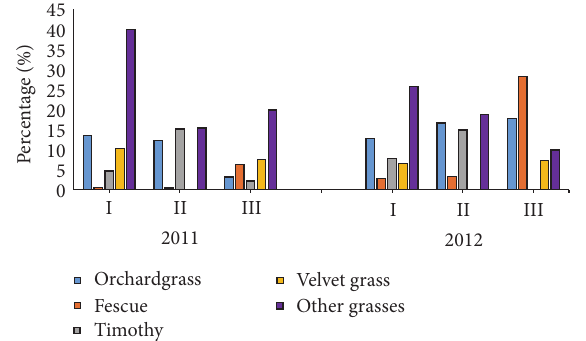
Figure 5: Proportion of dominant species in the forb component of grasslands used for winter grazing in three consecutive grazing intervals (I, II, and III) at Reedsville, WV. Grazing interval: I = naturalized permanent grazingland, II = orchardgrass cultivated pastureland, and III = tall fescue cultivated